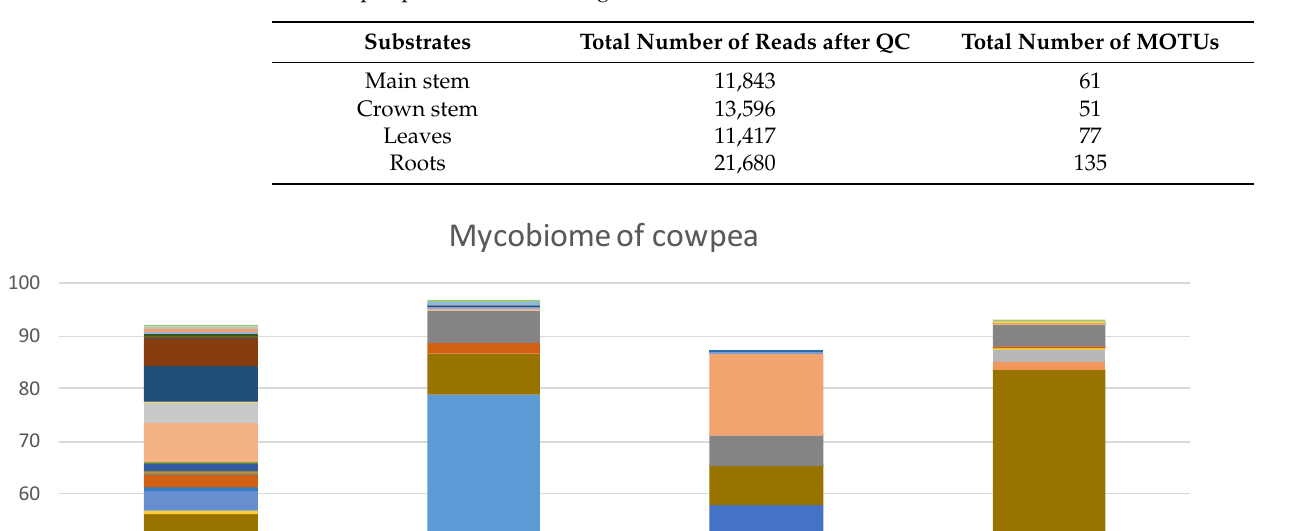
Table 1. Statistical summary of reads and Molecular Operational Taxonomic Units (MOTs) for the four cowpea plant tissues investigated.